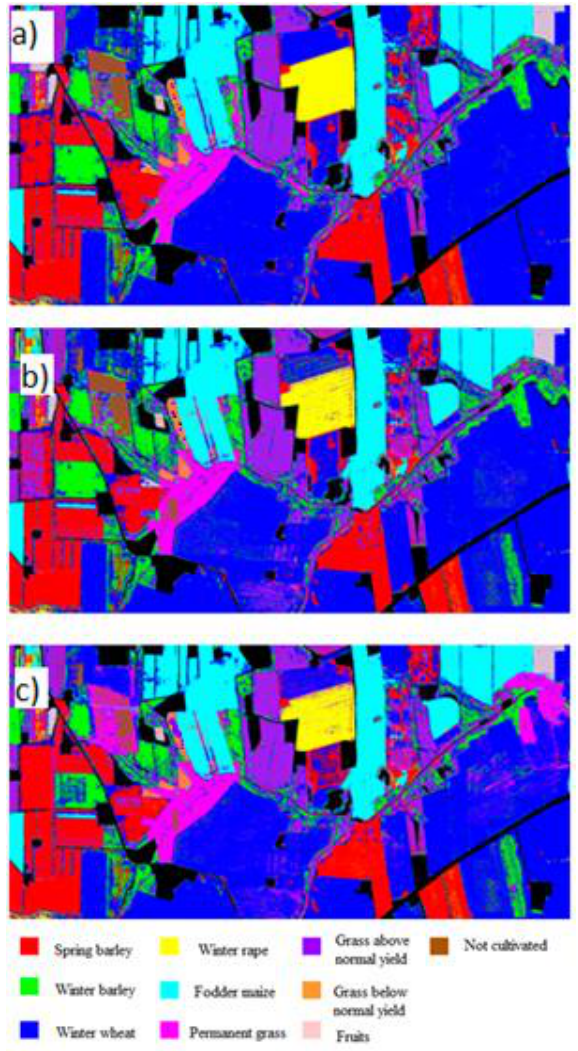
Figure 9. Classification output based on training samples selected by a) border samples from ECRA b) Random selection c) Non-refined border